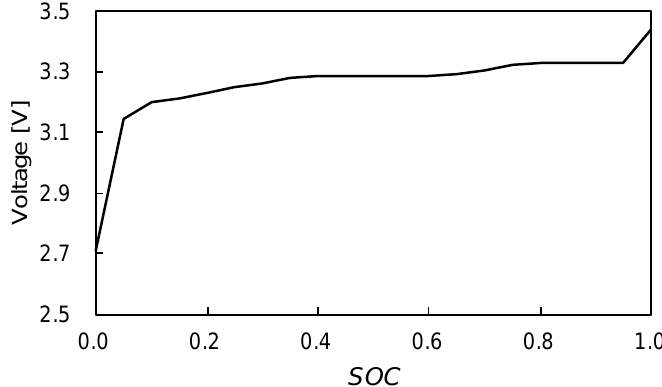
Figure 5. Relationship between the state of charge (SOC)-open circuit voltage (OCV) curve.